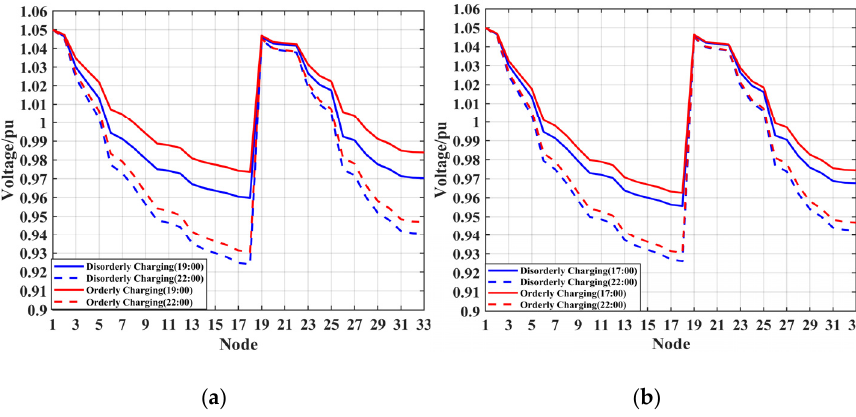
Figure 9. Voltages of the IEEE-33 distribution network: ( a ) weekday, ( b ) weekend.